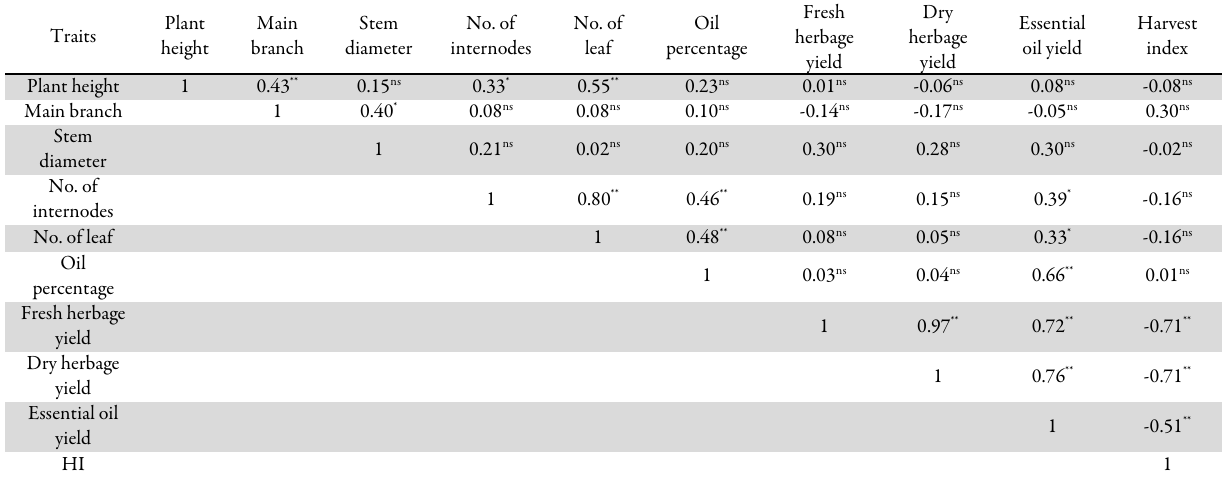
Table 4. Correlation analysis between traits of two species of mint exposed to various fertilizers’ treatments